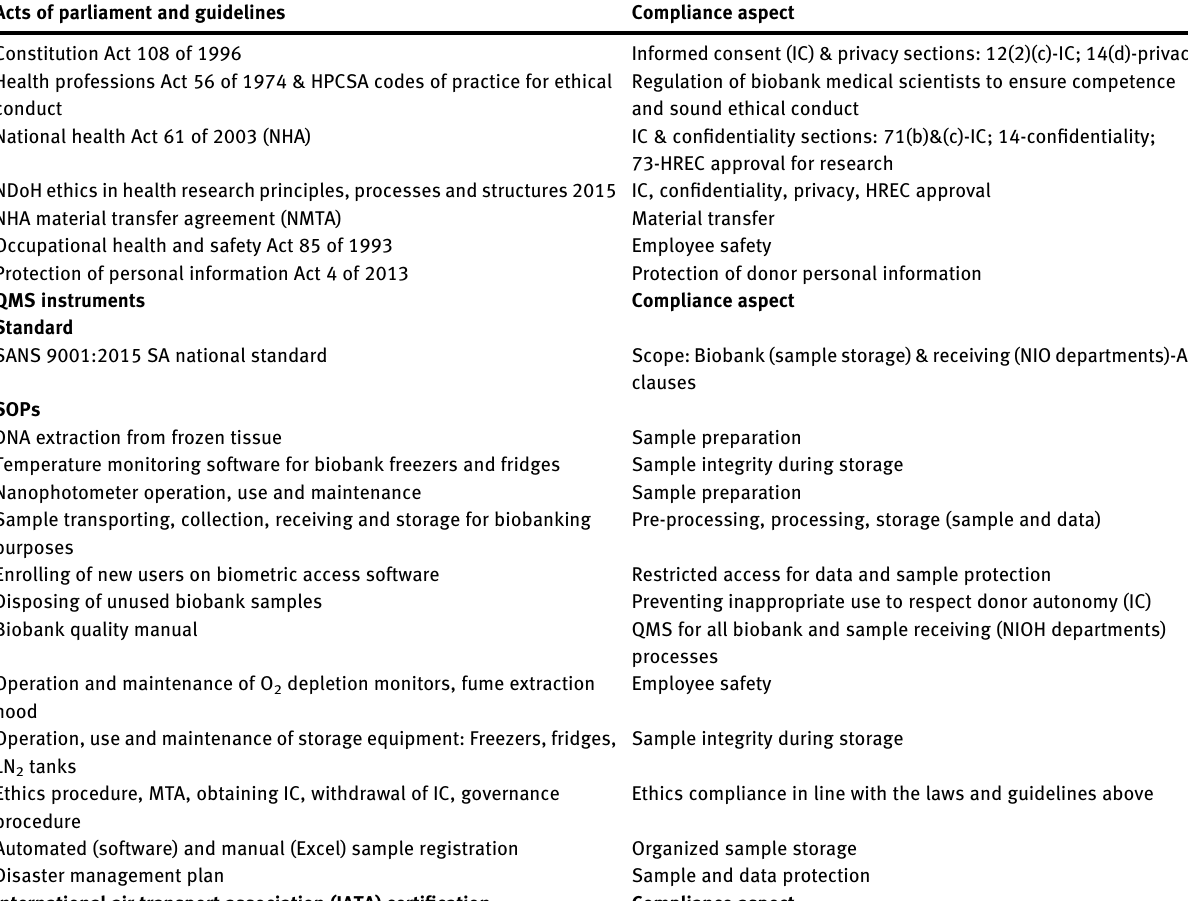
Table  : Regulatory framework and compliance